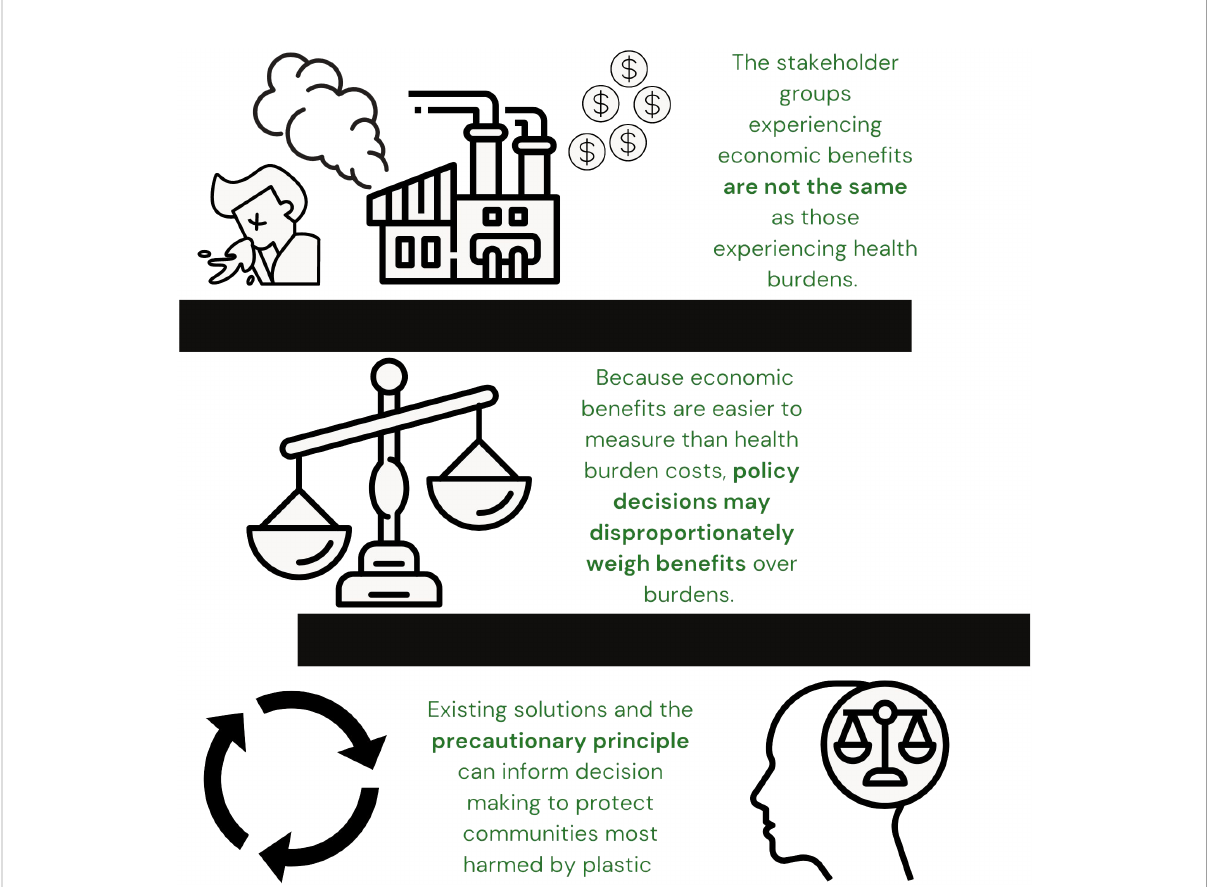
FIGURE 3 Key takeaways from assessment of bene fi ts and burdens. iconsy, ninjastudio, Icons8, narathip, pongsakornjun, anna design A4, and Graphic